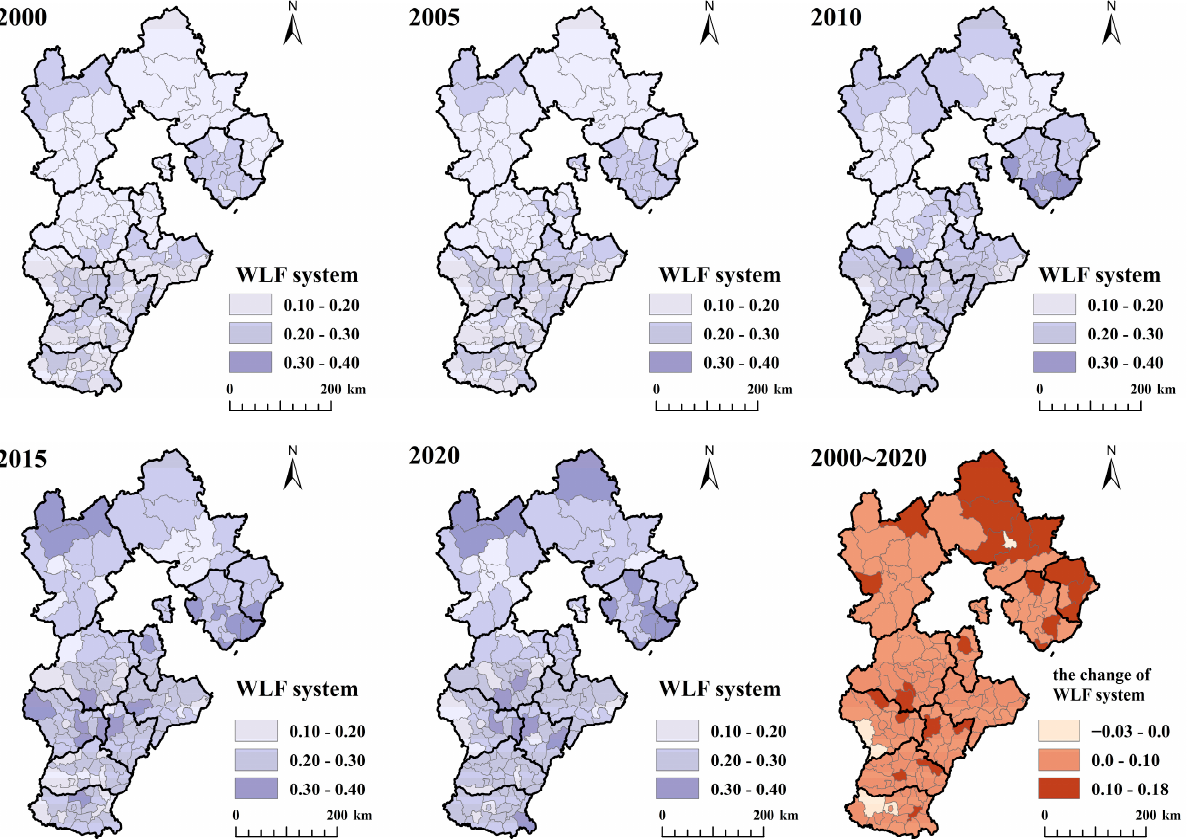
Figure 3. Spatial-temporal evaluation index of the WLF nexus system in 151 counties of Hebei province.